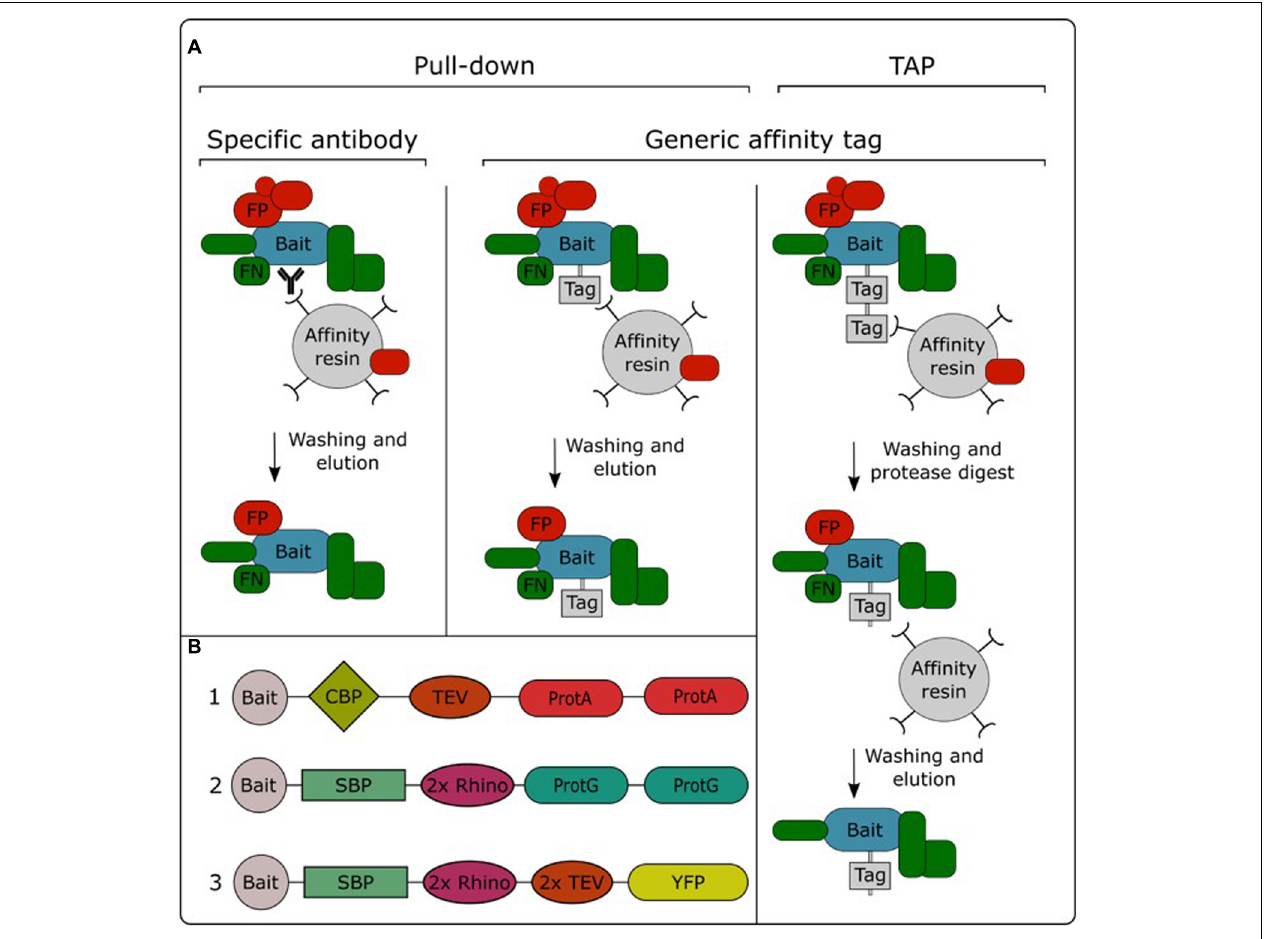
FIGURE 2 | Overview of the different AP/MS approaches (A) and available TAP tags (B) . TAP tags: (1) TAPi tag; (2) GSrhino tag; (3) GS yellow tag. CBP, calmodulin binding protein; FP, false positive; FN, false negative; ProtA, protein A domain; ProtG, protein G domain; 2x Rhino, double recognition site for the Rhinovirus 3C protease; TEV, recognition site for the tobacco etch virus protease; SBP, streptavidin-binding peptide; YFP, yellow fluorescent